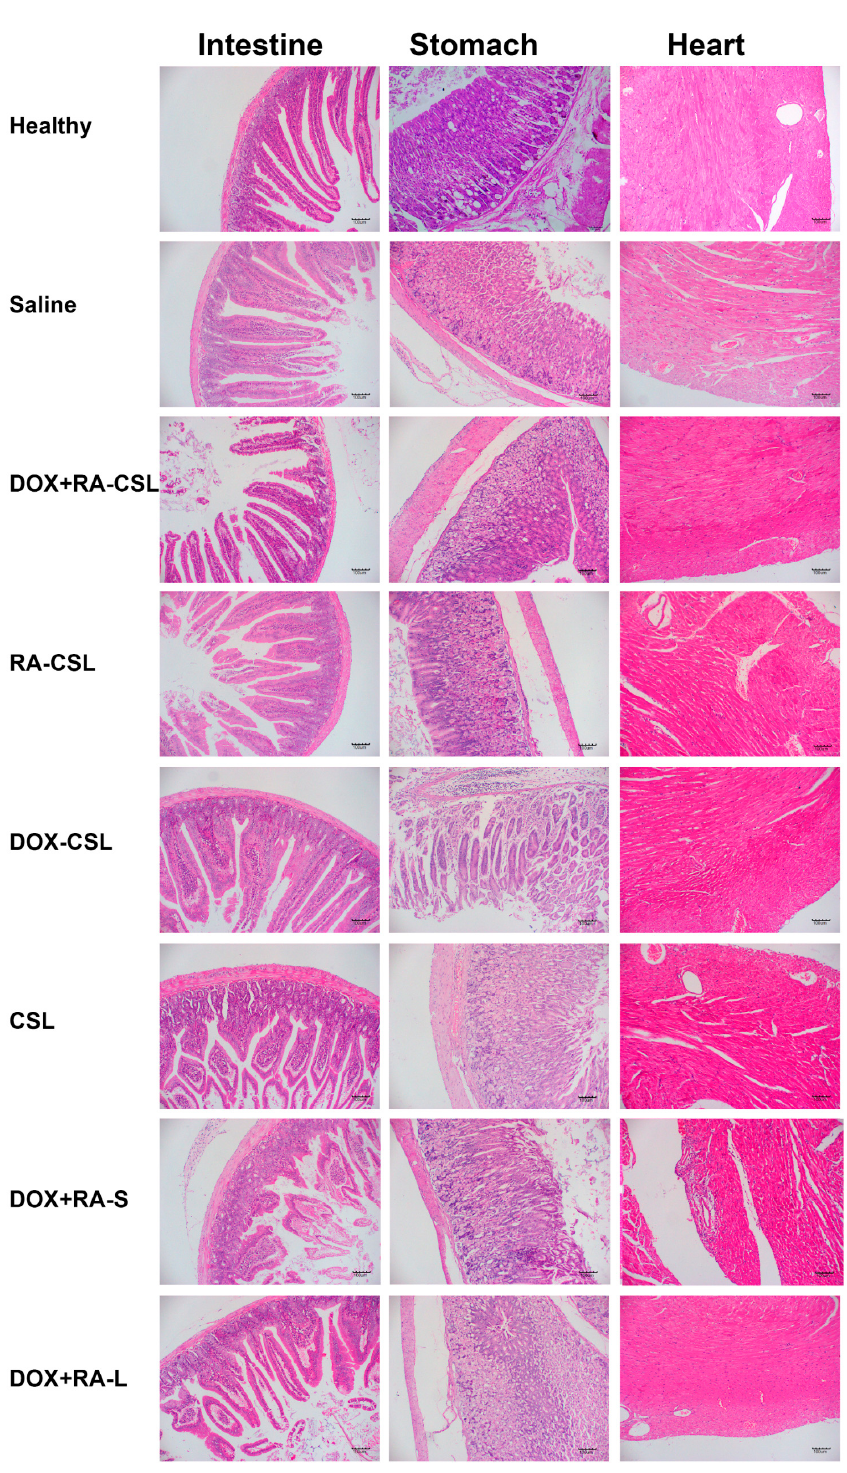
Figure 6. Safety profile of DOX+RA-CSLs determined by H&E staining of intestine, stomach, and heart tissues harvested from mice receiving various treatments. CSLs: chondroitin sulfate liposomes; RA-CSLs: retinoic acid-loaded CSLs; DOX-CSLs: doxorubicin-loaded CSLs; DOX+RA-S: DOX/RA solution; DOX+RA-Ls: liposomes co-loaded with DOX and RA; DOX+RA-CSLs: CSLs co-loaded with DOX and RA.